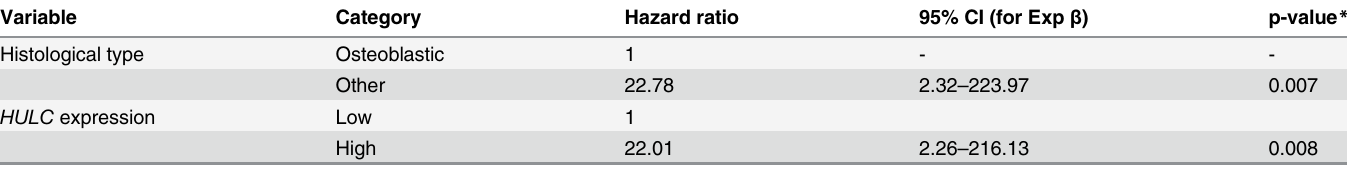
Table 4. COX regression model of the event-free survival for the OS